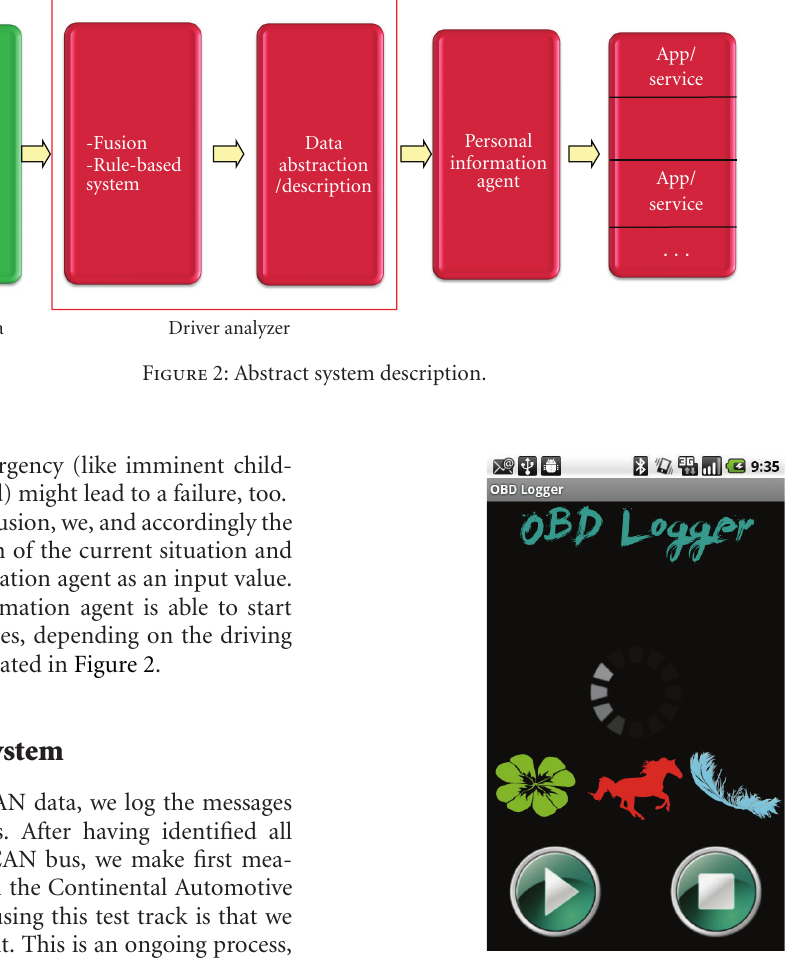
Figure 3: OBD2 Logger. One can see the three modes ecological (green), sporty (red), and comfort (blue), as well as the start button at the lower left and the stop button